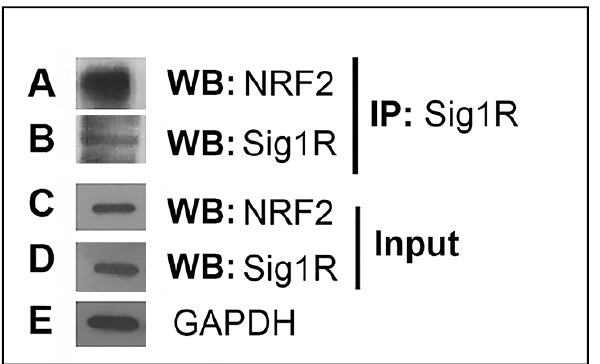
Figure 1. Co-immunoprecipitation of Sig1R and Nrf2 in 661 W cells. Lysates of 661 W cells were incubated with anti-Sig1R antibody and immune complexes were precipitated by protein A/G beads. The Sig1R complex was subjected to immunoblotting to detect ( A ) NRF2 and ( B ) Sig1R in the complex. The whole cell lysate was used for immunoblotting to detect ( C ) NRF2 and ( D ) Sig1R. ( E ) GAPDH served as an internal reference for sample loading.